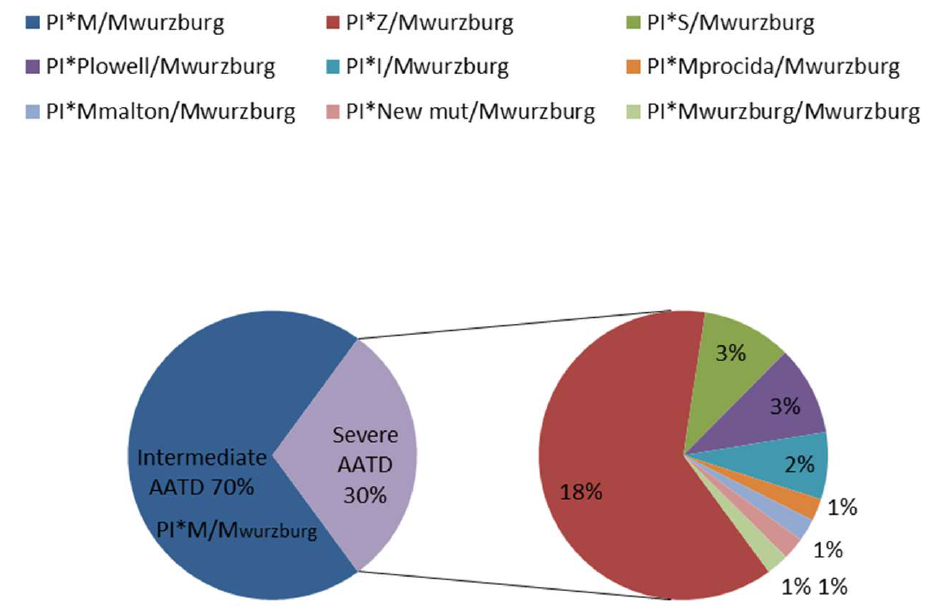
Figure 3. Frequencies of genotypes carrying the M wurzburg allele analysed in the Centre for Diagnosis of Inherited Alpha-1 Antitrypsin Deficiency in Pavia in the last 16